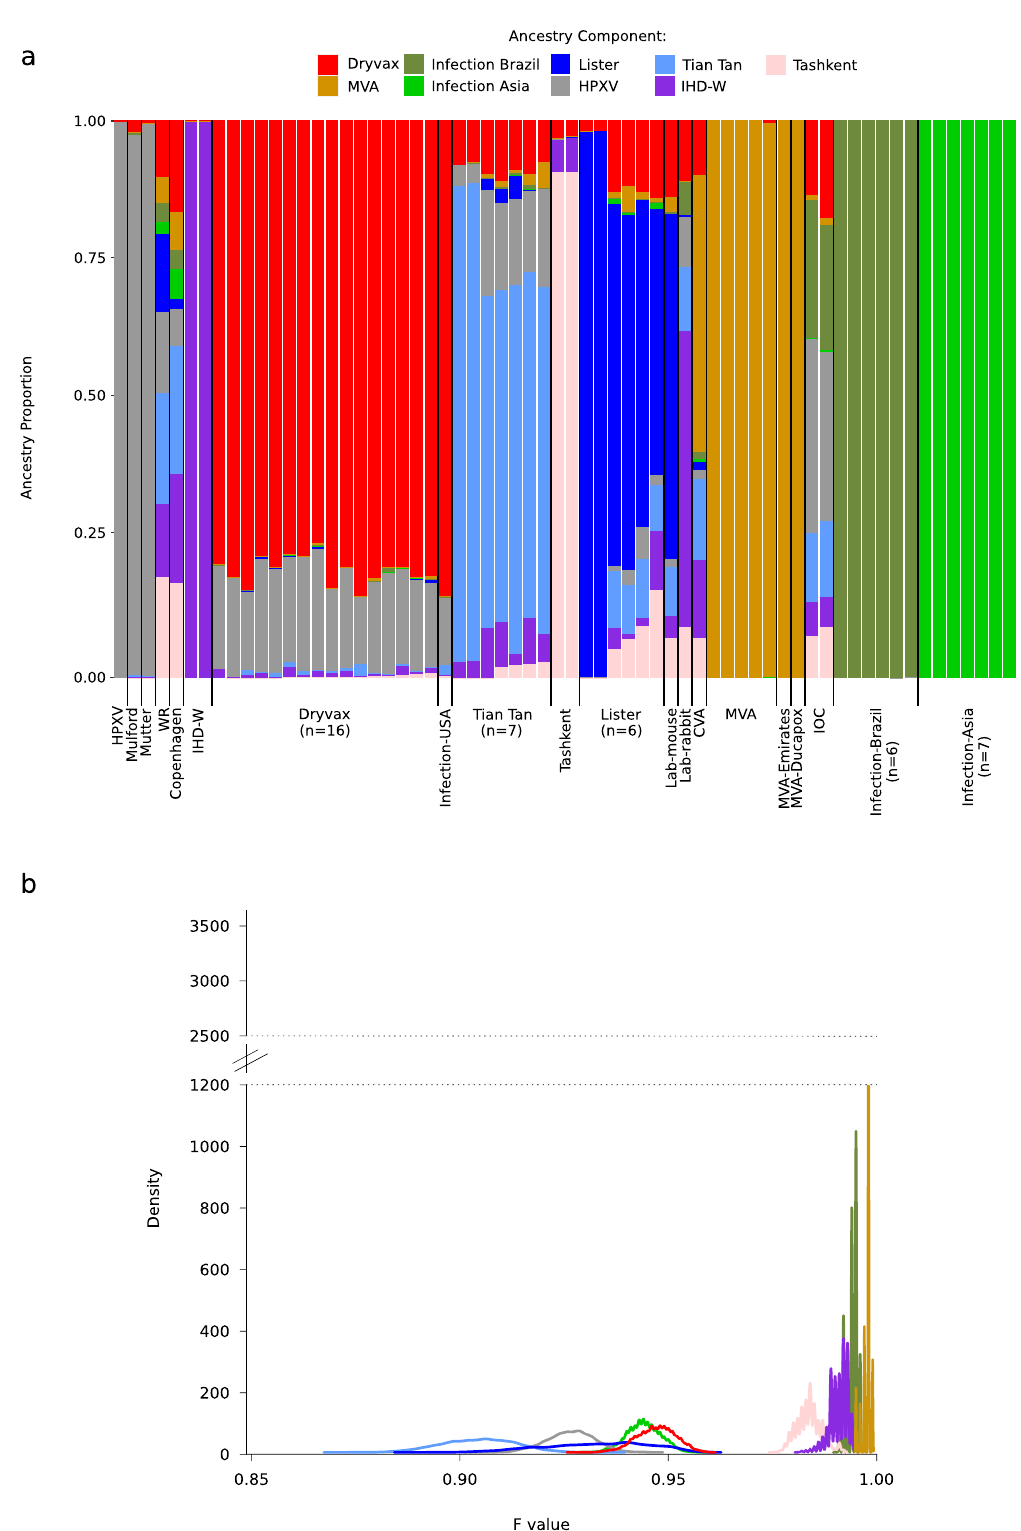
Fig. 3 Population structure of vaccinia virus. a Bar plot representing the proportion of ancestral population components for K = 9. Each vertical line represents a VACV genome and it is colored by the proportion of sites that have been assigned to the nine populations by STRUCTURE. Ancestry components are named based on the genomes where they are more prevalent. b Distributions of F values for the nine populations. Colors are as in panel a. Y axis is cut to better display all density